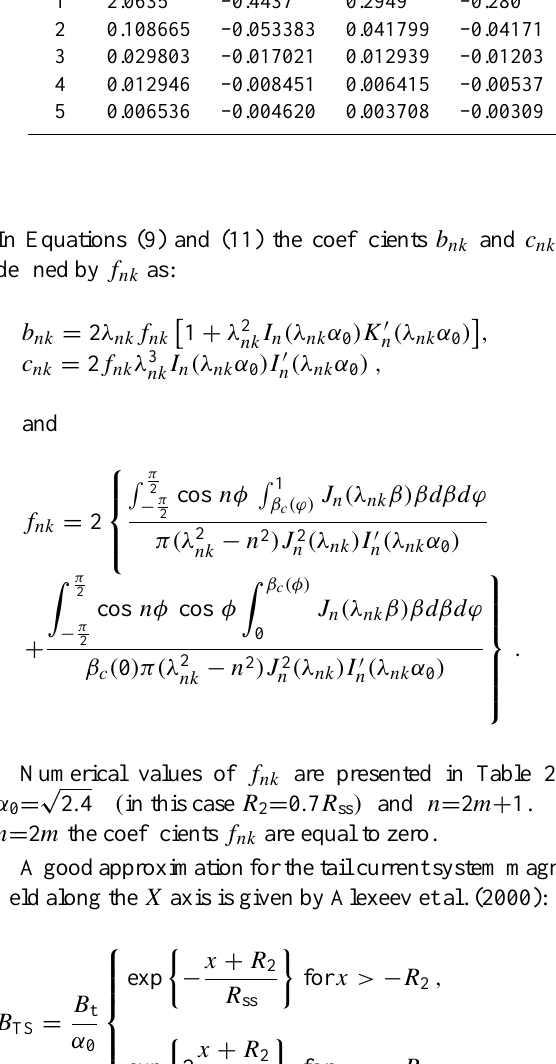
Table 2. Numerical values of the coefficients f nk of scalar potential U t of the tail current system. k \